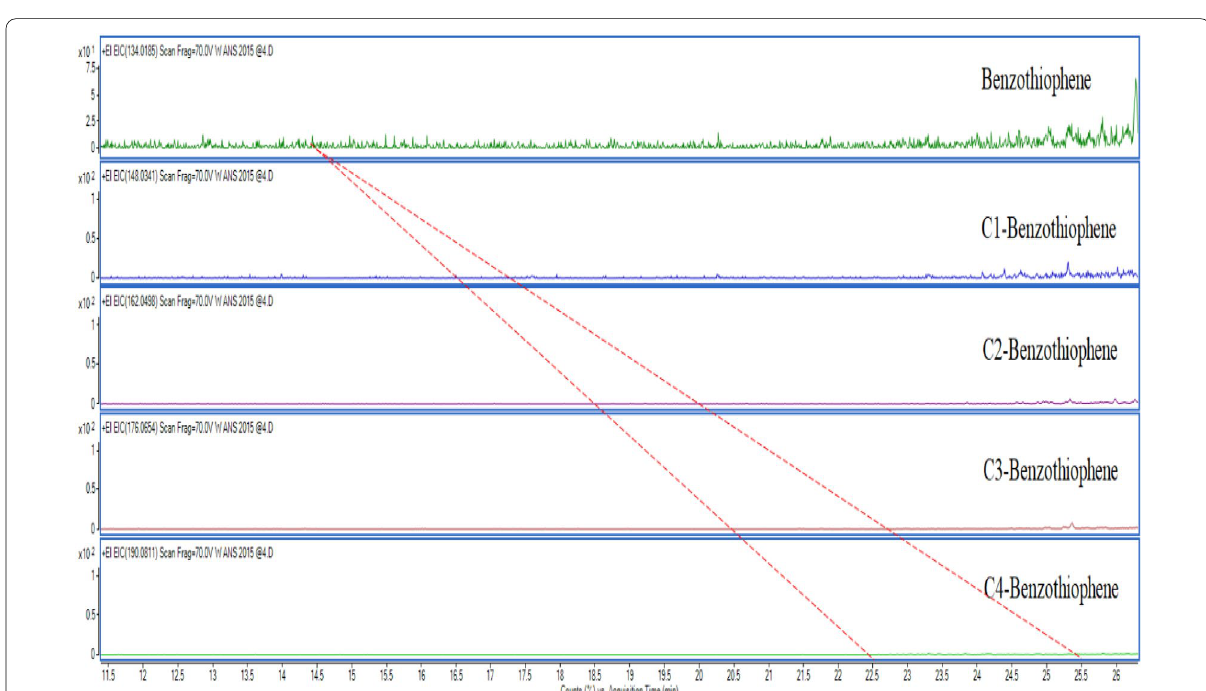
Fig. 1 Extracted (mass accuracy 50 ppm) ion chromatograms for Benzothiophene, C1–C4 Benzothiophene for weathered ANS